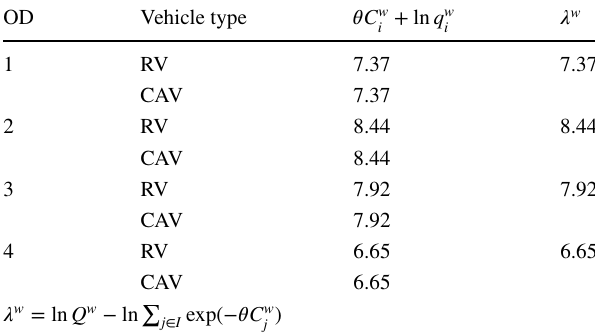
Table 4 Validation of the vehicle type choice equilibrium OD Vehicle